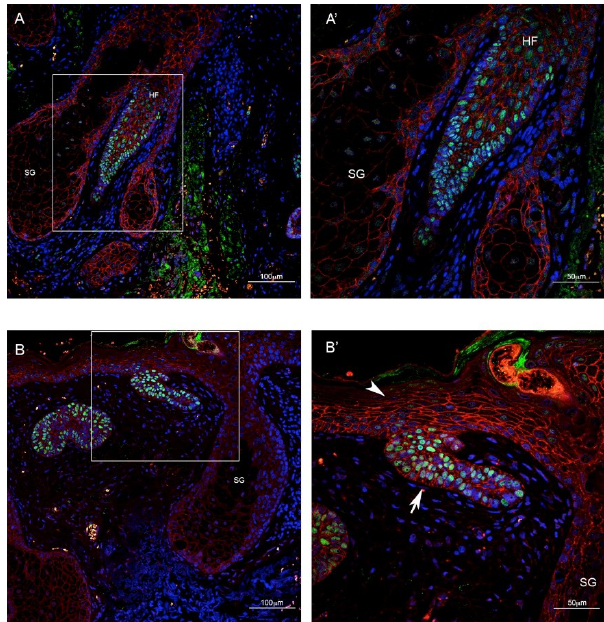
Figure 1. Immunofluorescence of skin biopsies from patients affected by BCC. ( A ) TBX1 (green), E-cadherin, an epithelial cell marker (red), and 4′,6‐diamidino‐2‐phenylindole (DAPI), which stains DNA (blue) showing the physiological expression of TBX1 in the hair follicle (HF, magnified in A’ ). ( B ) BCC connected to the epidermal layer: TBX1 is expressed in cancer cells (arrow, magnified in ( B’ ) but not in healthy epidermis (arrowhead). SG: Sebaceous gland. Scale bar is 100 μm in ( A , B ), 50 μm in ( A’ , B’ ).